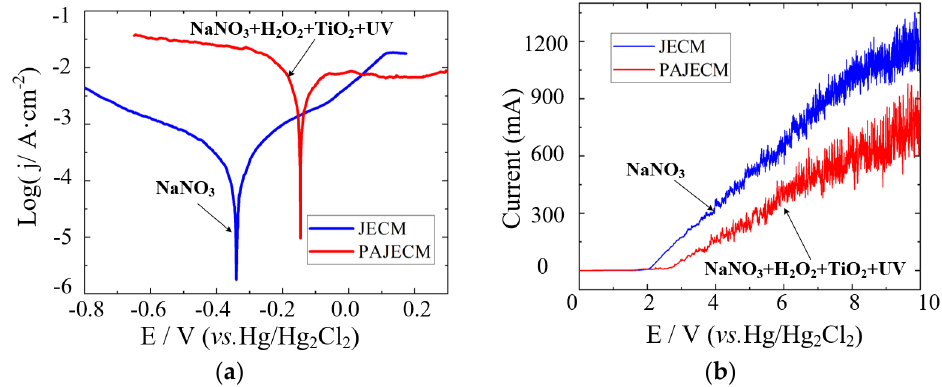
Figure 9. Comparison of electrochemical polarization curves at different processing conditions: ( a ) Tafel curve; ( b ) decomposition voltage curve.